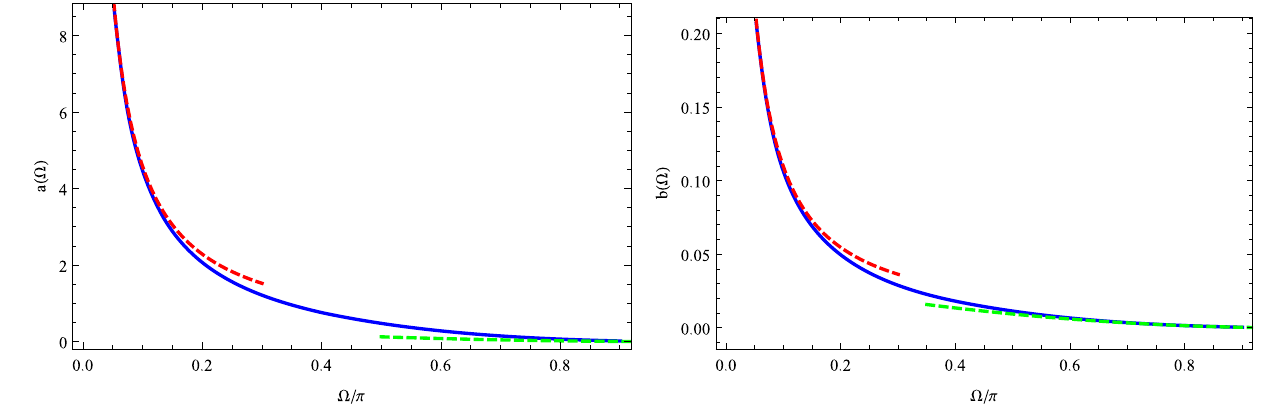
Fig. 1 The plots for the function a ((cid:16)) (left panel) and b ((cid:16)) (right panel). For small opening angle (cid:16) → 0, one has to leading order ) 4 /(π(cid:16)) and b ((cid:16)) = 3 (cid:20)( 3 a ((cid:16)) = 2 (cid:20)( 3 4